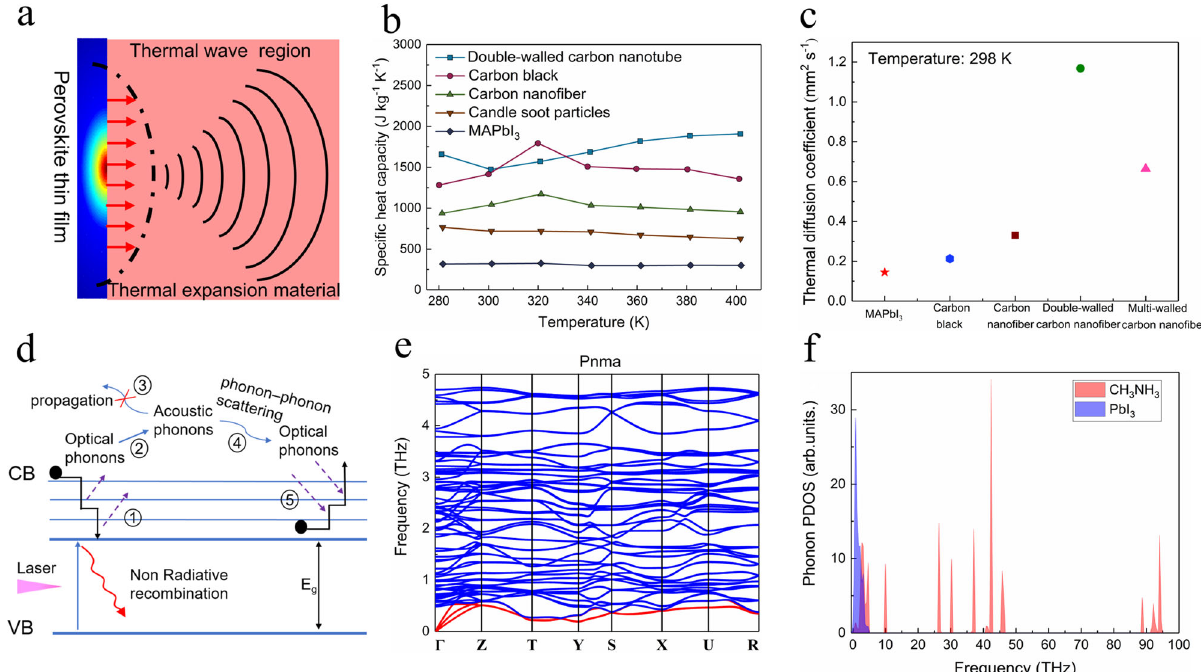
Fig. 2 The analysis of thermal properties of MAPbI 3 . a The mechanism of the optoacoustic transducers. The blue rectangle is the perovskite fi lm and the pink part represents the thermal expansion material. b Measured speci fi c heat capacity of perovskites and other representative absorbers. The double- walled carbon nanotube, carbon black, carbon nano fi ber, candle soot particles, and MAPbI 3 are labeled as cyan rectangle, red circle, light green triangle, the brown inverted triangle, and blue diamond, respectively. c Measured thermal diffusion coef fi cient of different light absorption materials. The red star, blue hexagon, dark red rectangle, green circle, and pink triangle represent MAPbI 3 , carbon black, carbon nano fi ber, double-walled carbon nanotube, and multi- walled carbon nanotube, respectively. d Schematic illustration of the heat generation process within MAPbI 3 . Here, the acronyms of CB and VB represents conduction band and valence band, respectively. The physical meaning of vertical axis is the energy levels. Speci fi cally, the arrows of ① – ⑤ represent the process of carrier relaxation. ① : The generation of optical phonons by the relaxation of high energy electrons in the conduction band; ② : The excited optical phonons decay to acoustic modes; ③ : the propagation of acoustic phonons within the crystal lattice; ④ : The phonon up-transition process (acoustic phonons → optical phonons) due to the energy overlap between the two modes; ⑤ : The charge carriers are reheated by the recycled thermal energy. e Calculated phonon spectrum of MAPbI 3 . The blue curve represents optical phonon spectrum and the red curve represents acoustic phonon spectrum. f Density of states of the phonon